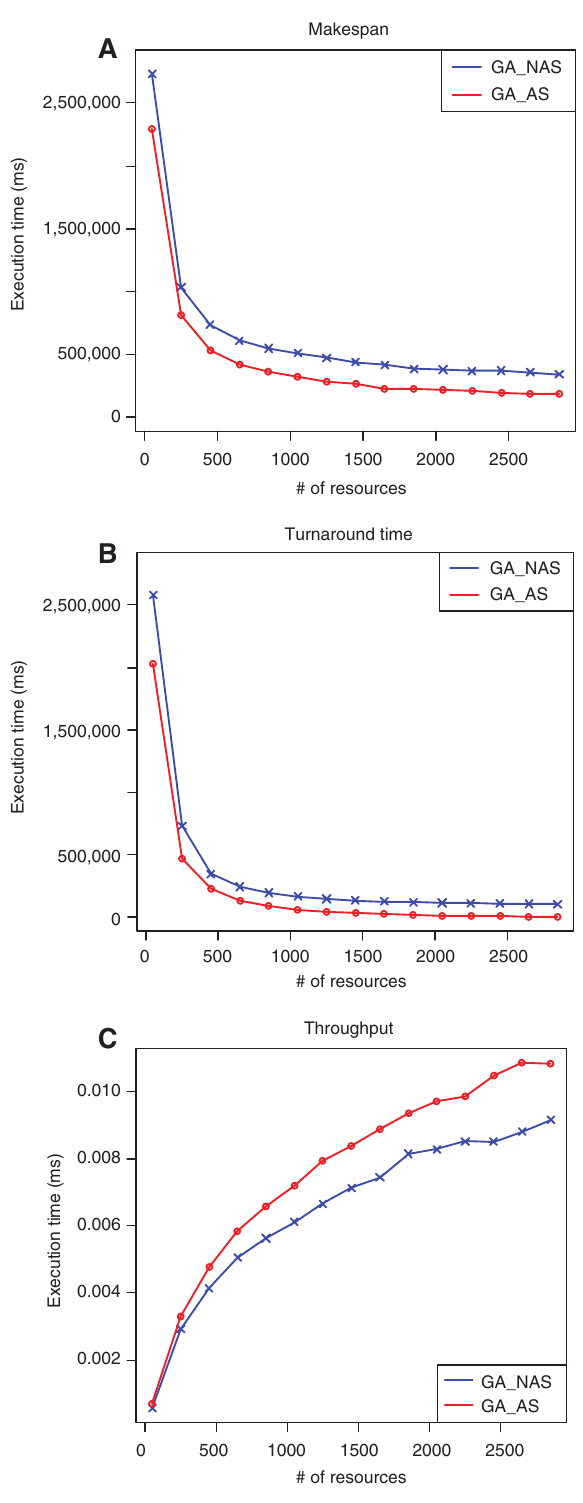
Figure 6: Performance Comparison of Resource Allocation by GA-AS and GA-NAS. (A) Makespan. (B) Turnaround time. (C)